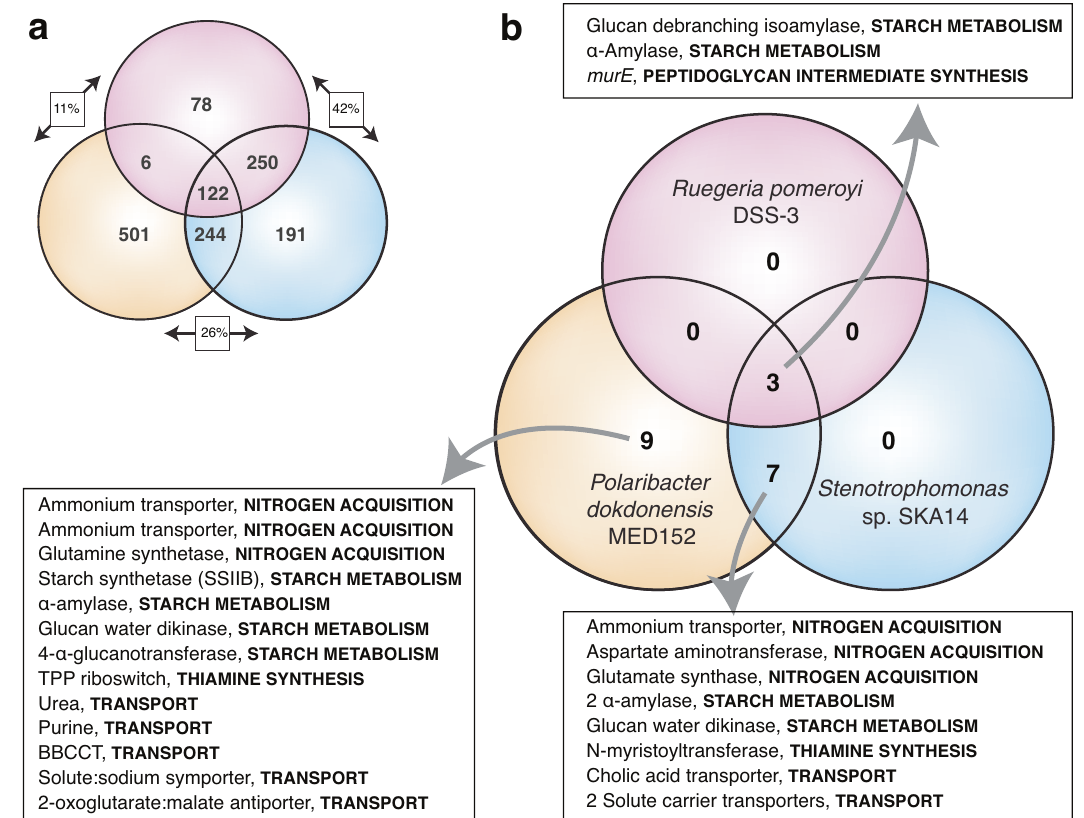
Fig. 2 M. commoda transcript enrichment in the presence of one or more of the three heterotrophic bacteria. a Transcription was enriched for 1393 genes in Micromonas across all treatments. Boxed values indicate pair-wise comparisons of the genes enriched in both species as a percent of the genes enriched in only one or the other. Complete gene information and fold-change values are given in Tables S5, S6, and S7. Signi fi cance was determined based on padj values ≤ 0.01. b Transcription was enriched for 19 potential substrate-related genes in Micromonas , 10 of which were found for more than one co-cultured bacterium. Complete gene information and fold-change values are given in Table